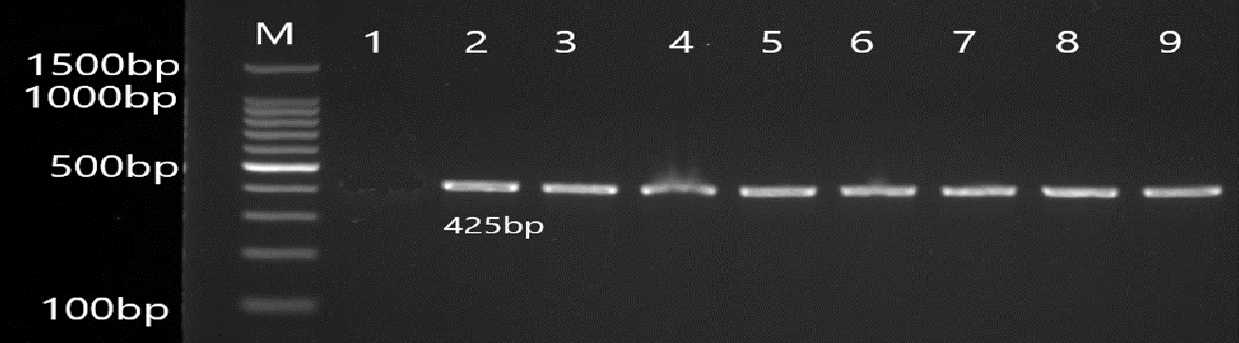
Figure 5. Electrophoresis showing amplicons of P. aeruginosa mexR gene. Lane M: 100 bp molecular marker, Lane 1: Negative control, Lane 2 – 9: Positive isolates of mexR gene .